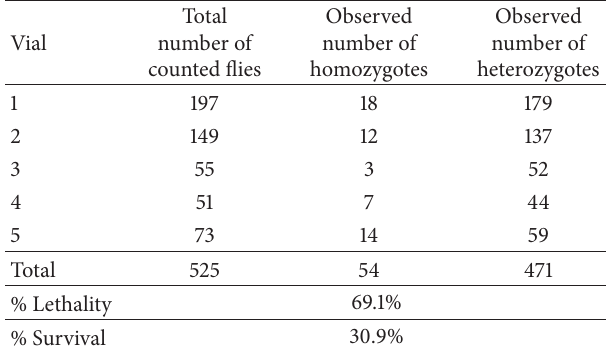
Table 2: The number of Ubx-YFP homozygous and heterozygous flies from crosses between heterozygous 𝑈𝑏𝑥 𝐶𝑃𝑇𝐼000601